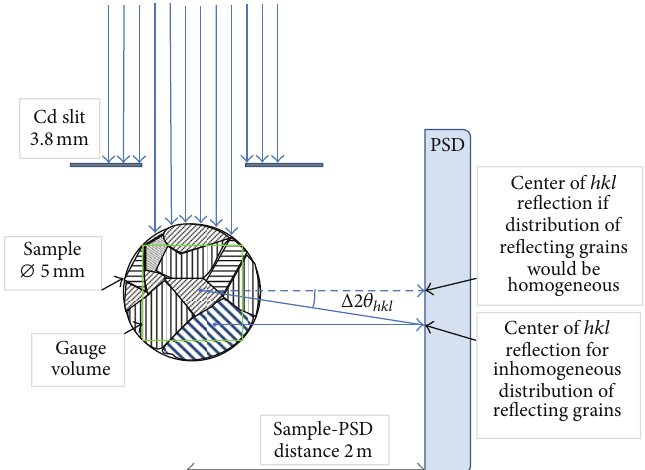
Figure 2: Scheme (top view) of the out-of-furnace measurement. If the sample is not 𝜔 -rotating in the range of 360 ∘ during the measurement, the reflection can be shifted by Δ2𝜃 ℎ𝑘𝑙 with respect to the expected position as it can originate from a large excentric grain. The Δ2𝜃 ℎ𝑘𝑙 shifts are different for different reflections as different grains